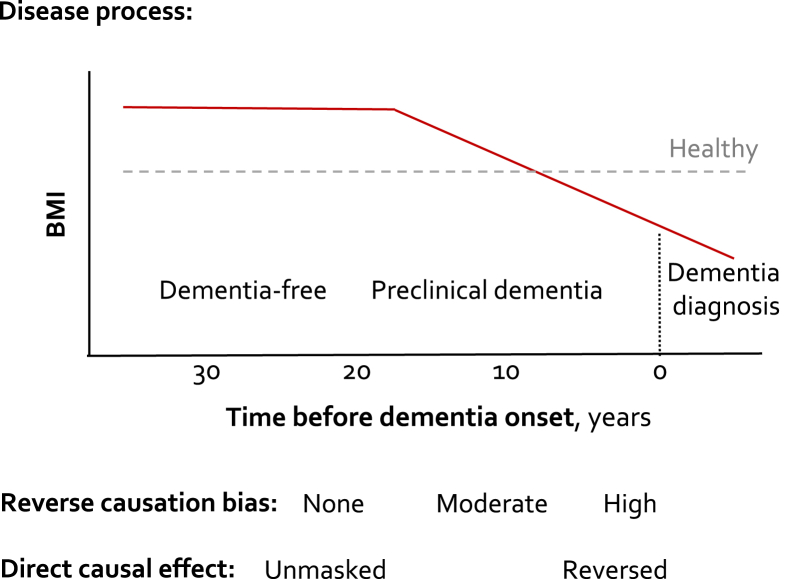
Conceptual model: Effect of reverse causation (preclinical disease reduces weight) on BMI at different etiological periods before dementia diagnosis. Abbreviation: BMI, body mass index.